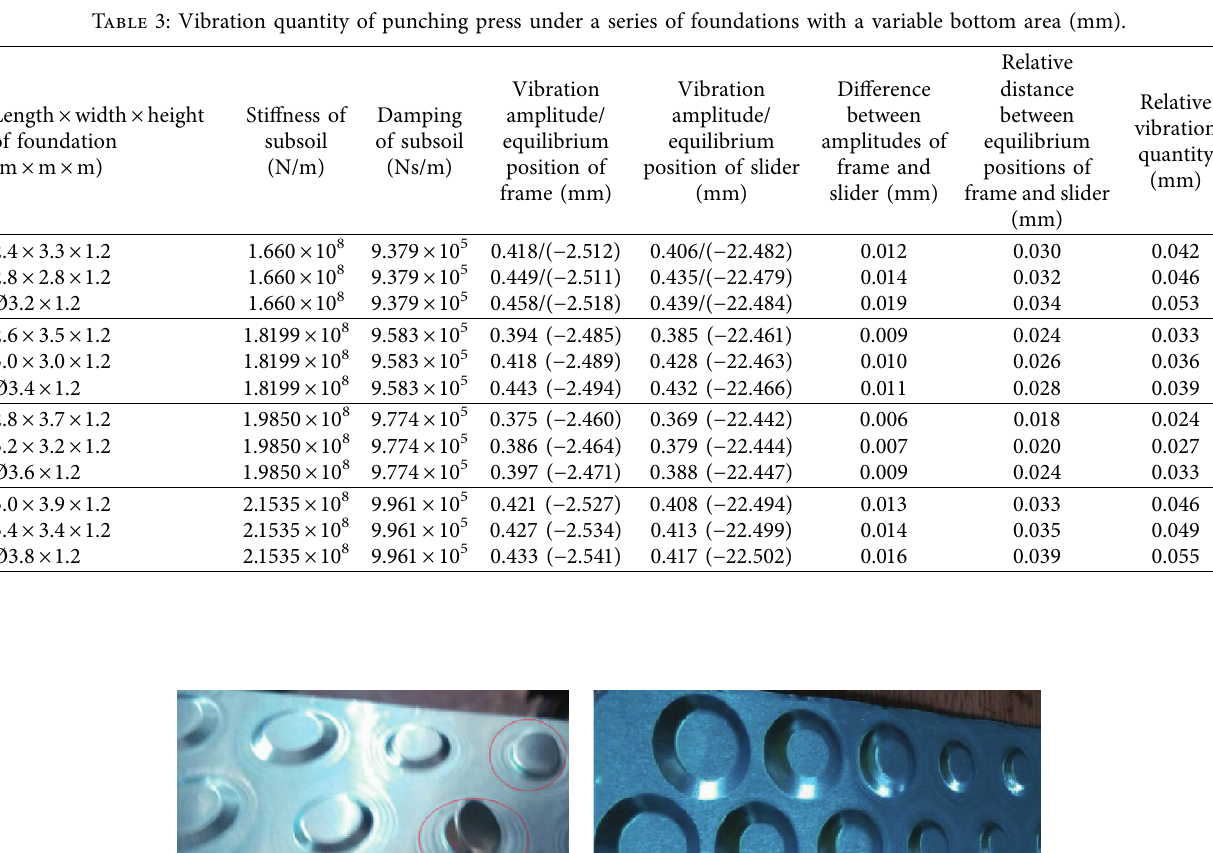
Table 3: Vibration quantity of punching press under a series of foundations with a variable bottom area (mm).